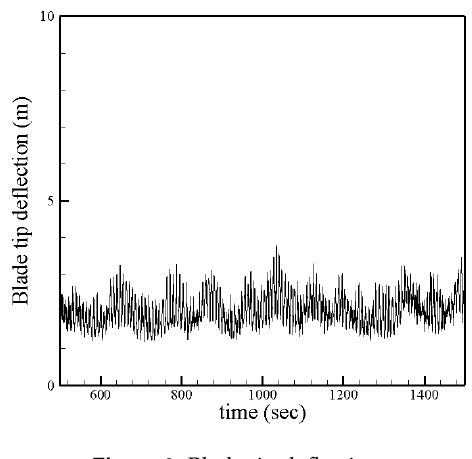
Figure 3. Blade tip deflection.